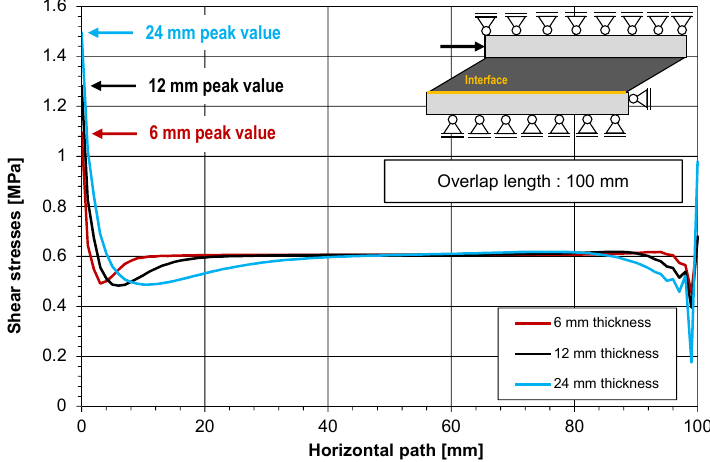
Fig. 24 Shear stress distribution in the silicone sealant at the interface to the adherend for different thicknesses and the same element size as well as the same applied engineering shear strain. A constant overlap length of 100 mm is